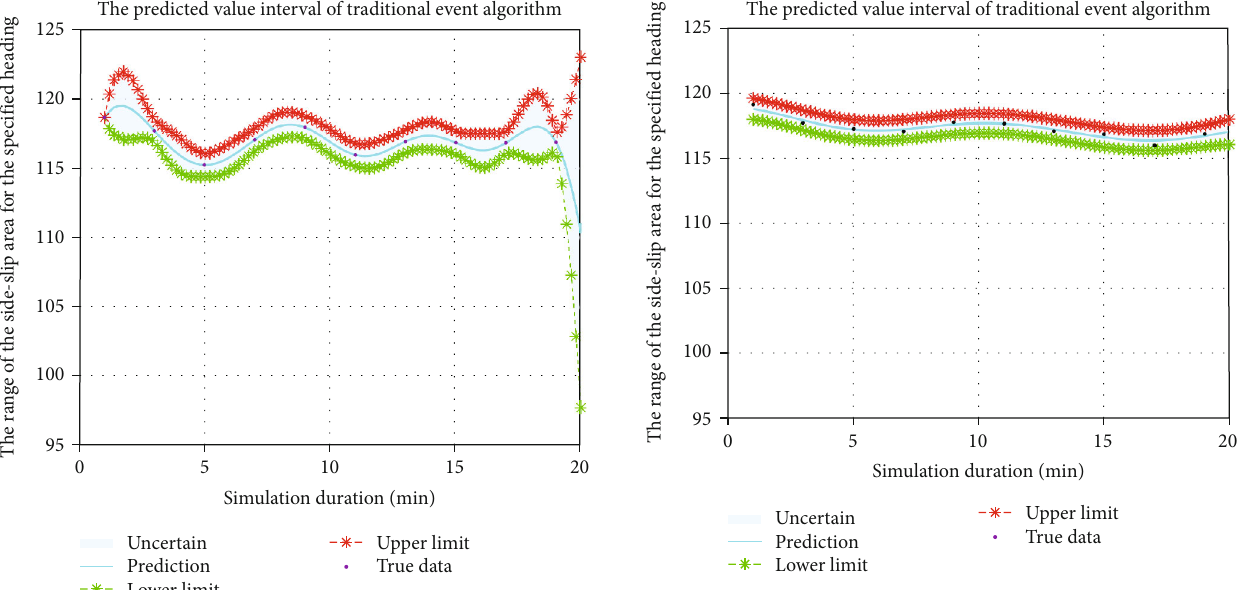
Figure 10: Prediction points and prediction intervals based on the traditional event model.